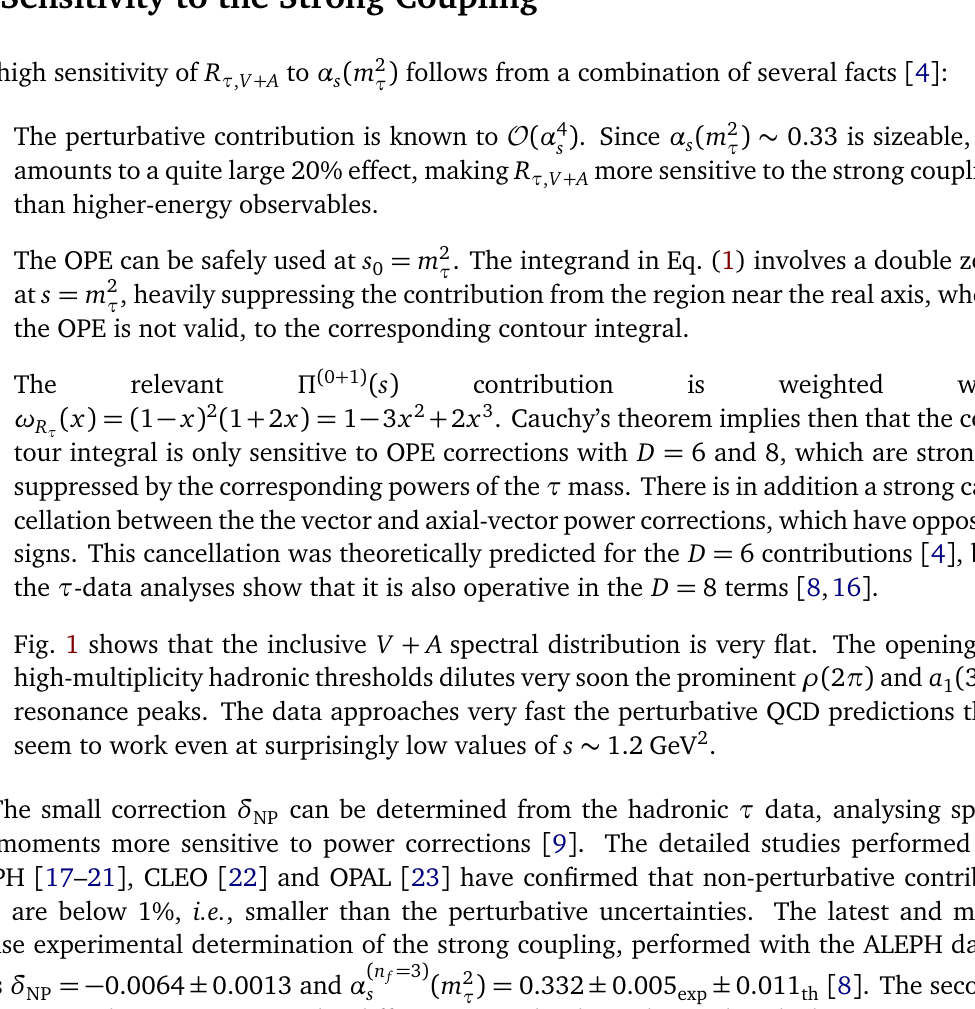
Table 1: Exact results for A ( n ) ( α and corresponding values of δ